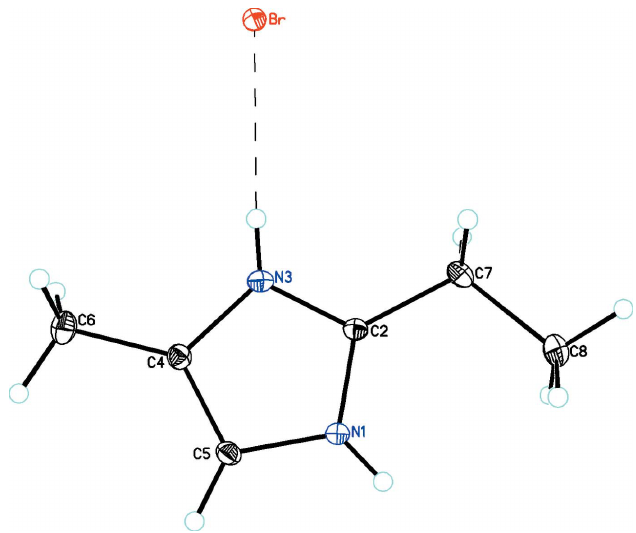
Figure 1 The molecular structure of 1 showing 30% displacement ellipsoids. The hydrogen bond is shown with a dashed